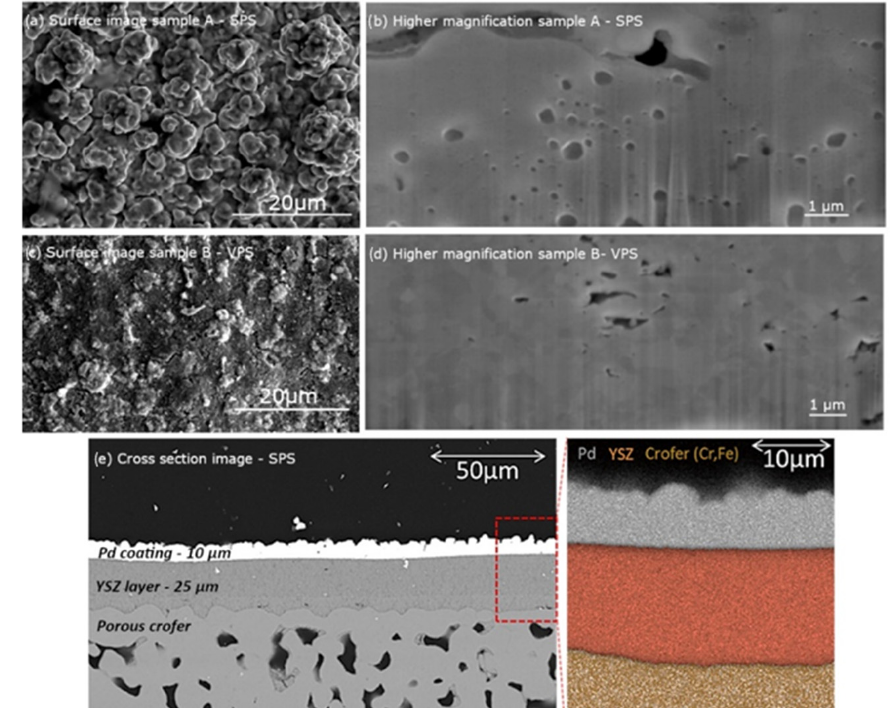
Figure 4. SEM micrographs of the samples using 30 kV, 1.6 nA. Secondary electron image of the surface showing the roughness of the layers for samples of SPS ( a ), and VPS ( c ). Cross-section view of the layers of SPS ( b ), and VPS ( d ). Backscattered detector cross section image (( e ) left) and EDX elemental mapping analysis (( e ) right) for SPS